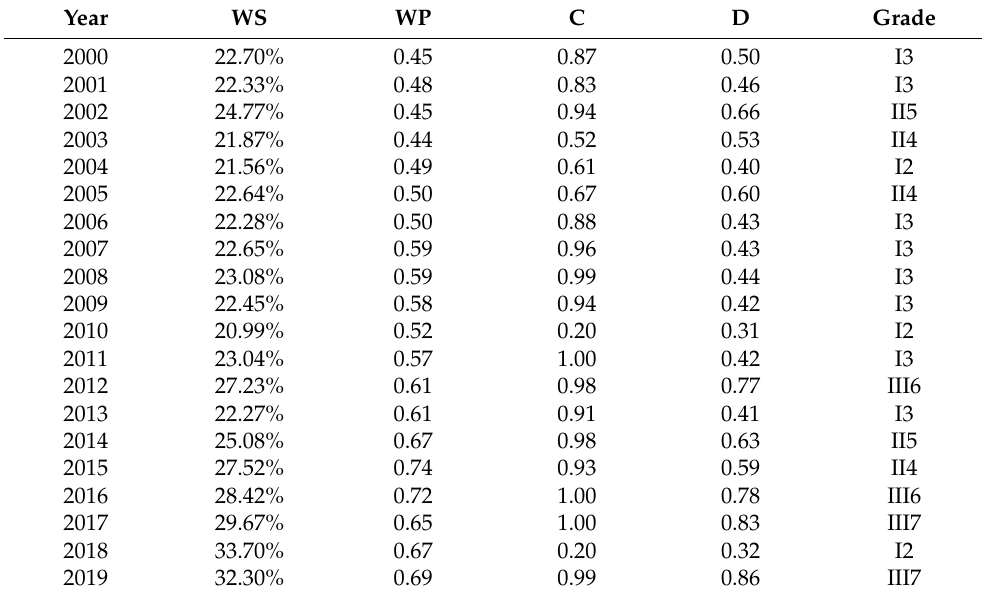
Table 5. Ecological security indicators of the WF in Hotan 2000–2019 and coordination